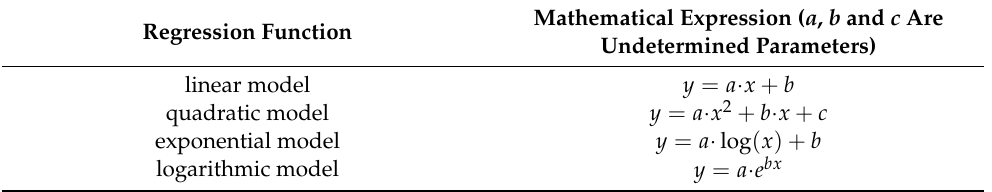
Table 1. The Traditional statistical Regression models. Regression Function